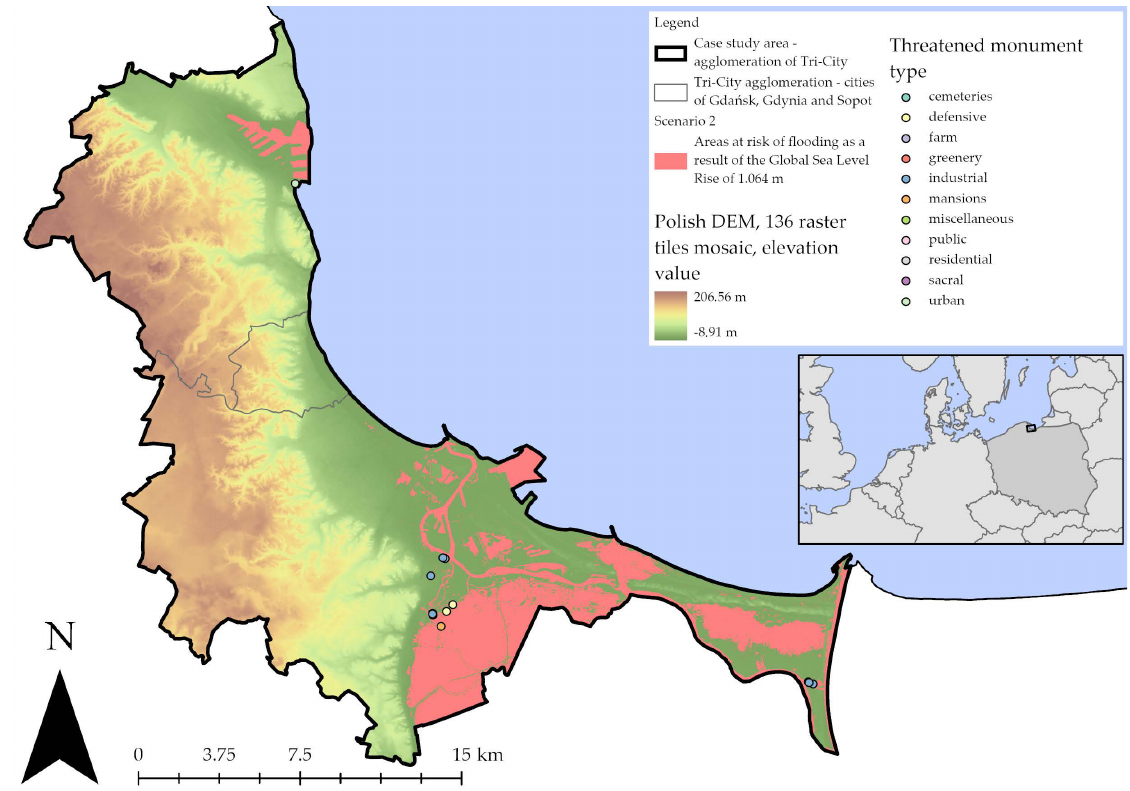
Figure 10. Global sea level rise scenario 2 for the case study area (the year 2100). Source: own elaboration using ArcGIS Pro 2.7, on the basis of the data from Polish